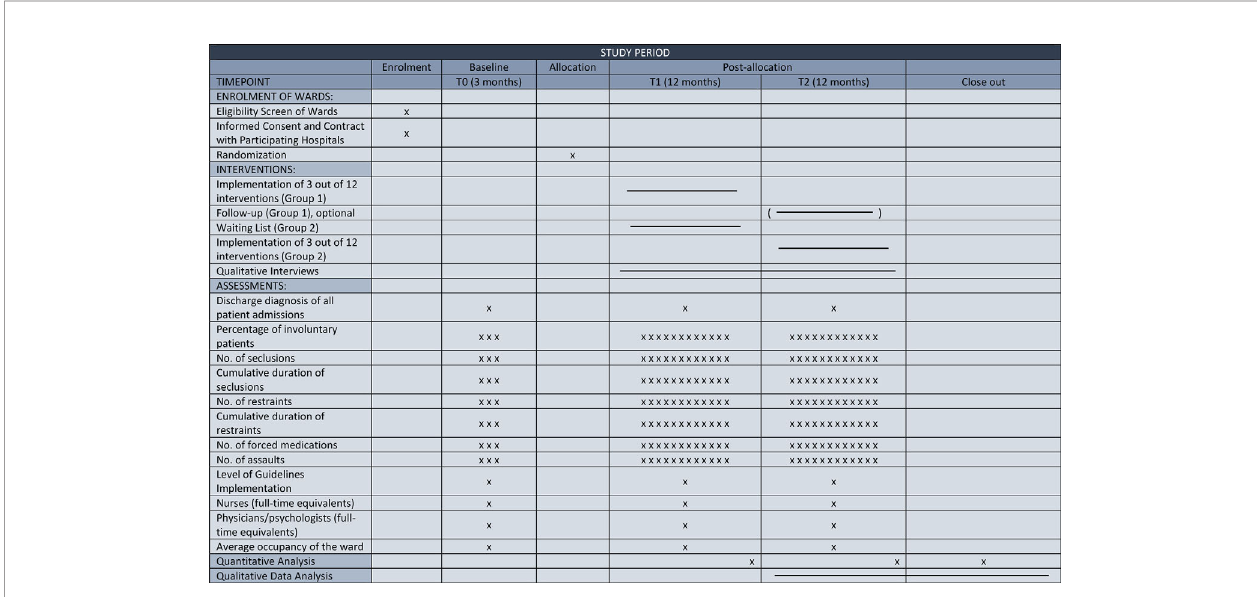
FIGURE 1 | SPIRIT fl ow chart: Timeline and study